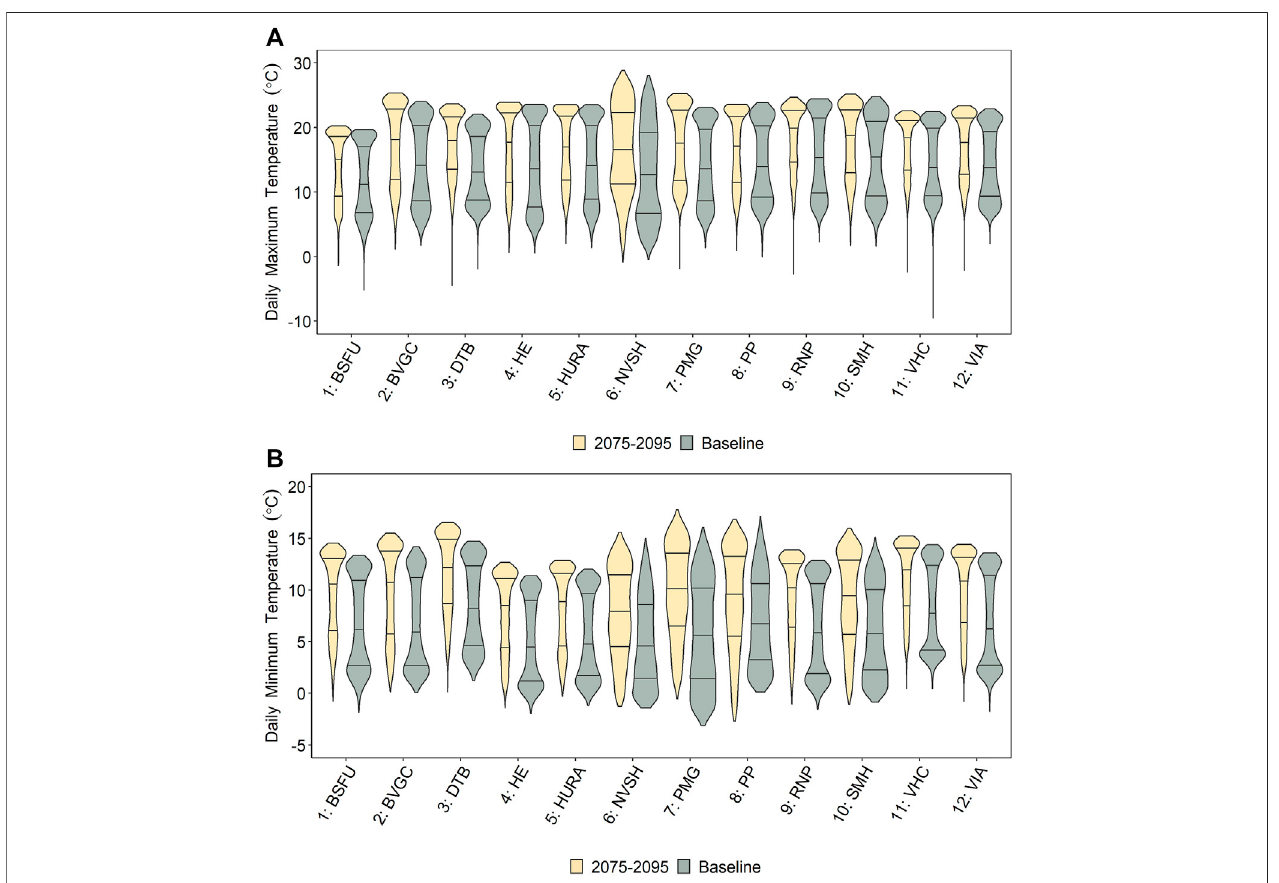
FIGURE 12 | Frequency distributions of daily maximum (A) and minimum (B) temperature between 2075 and 2095.